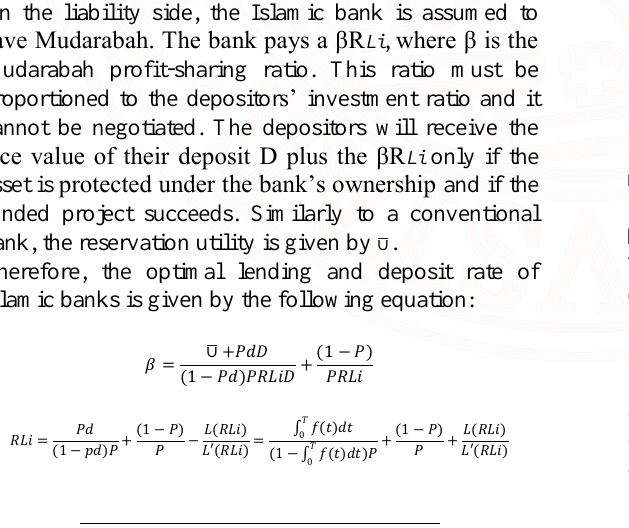
Model 1. IBFinTot = f (IBDepTot, PSRibfintot, CBRwc, IMMR, CPI, IPI) Model 2. MuraFin = f (PSRmurafin, CBRc, IMMR, CPI,